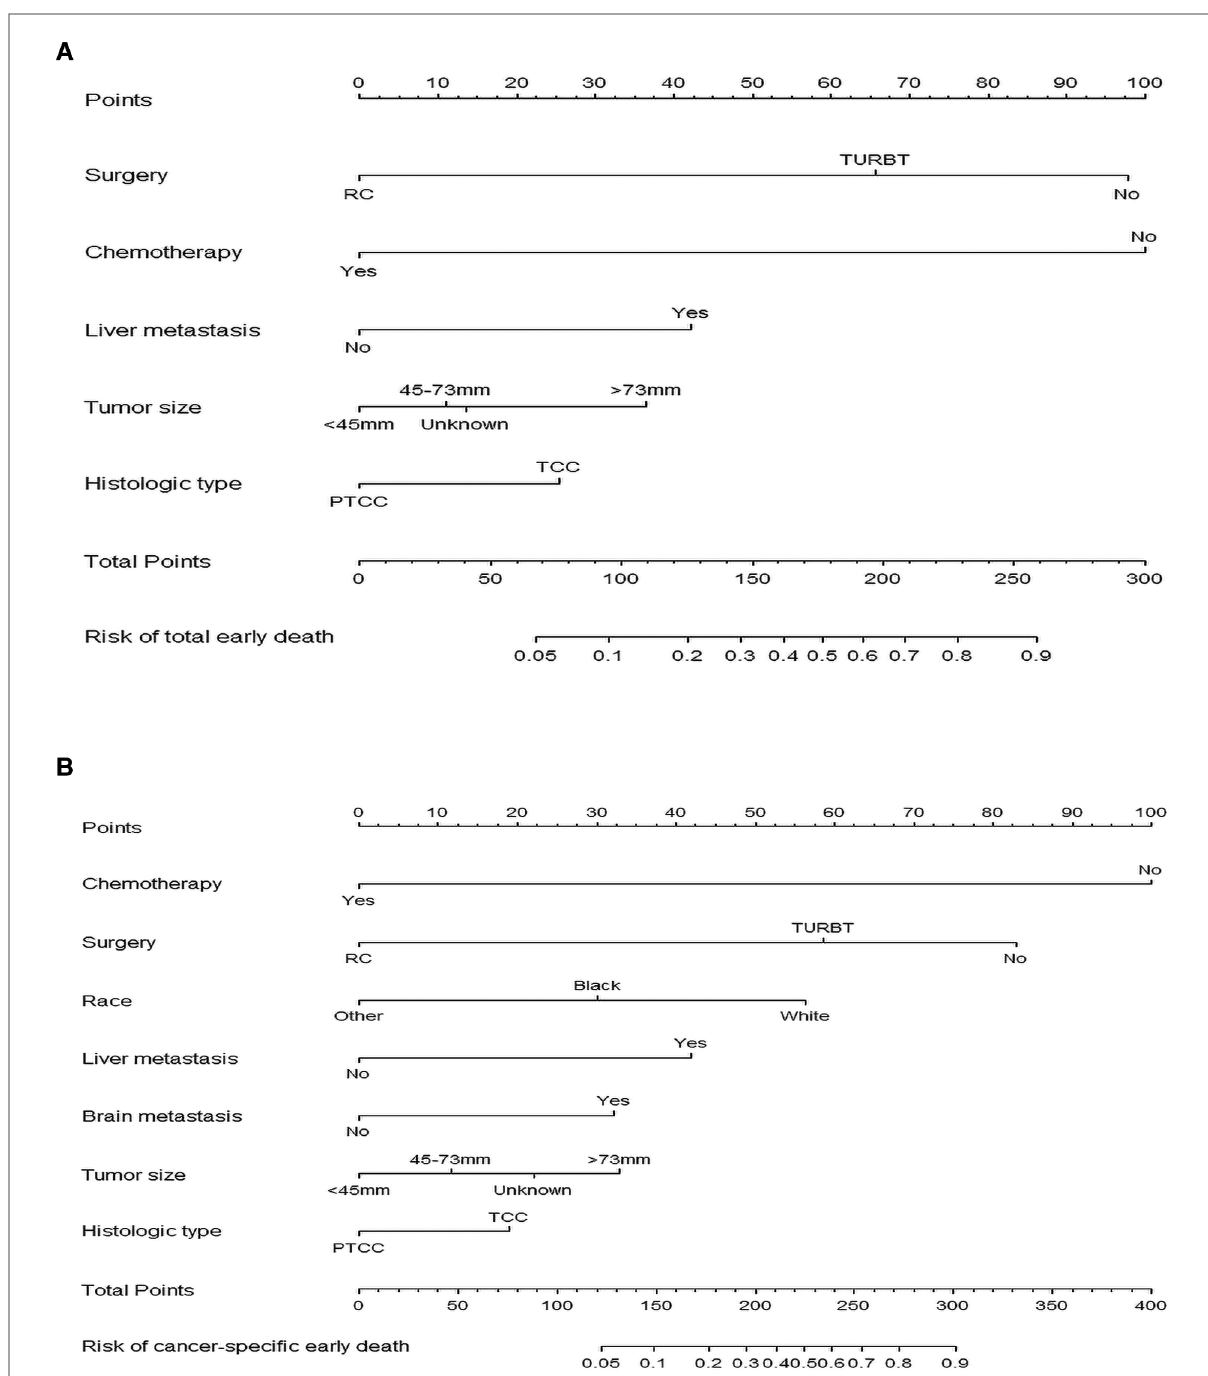
FIGURE 3 The nomograms of early death in patients with metastatic bladder cancer. ( A ) The total early death; ( B ) The cancer-speci fi c early